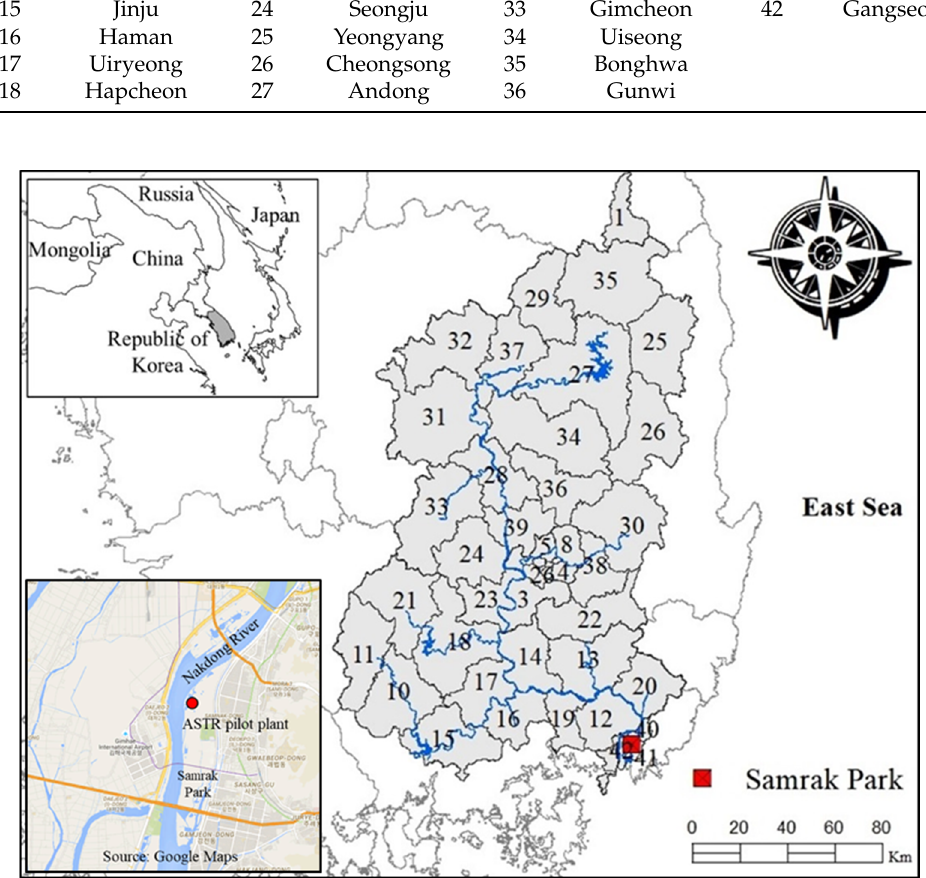
Figure 2. Location of the ASTR pilot plant and cities around the Nakdong River basin. Table 1. Numbers and names of cities on the map of Nakdong River basin.